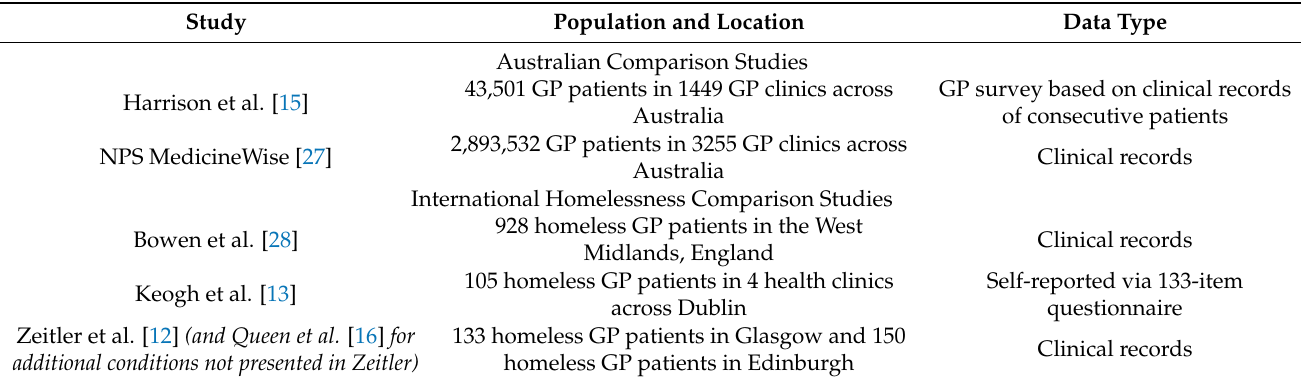
Table 1. Details of Comparison